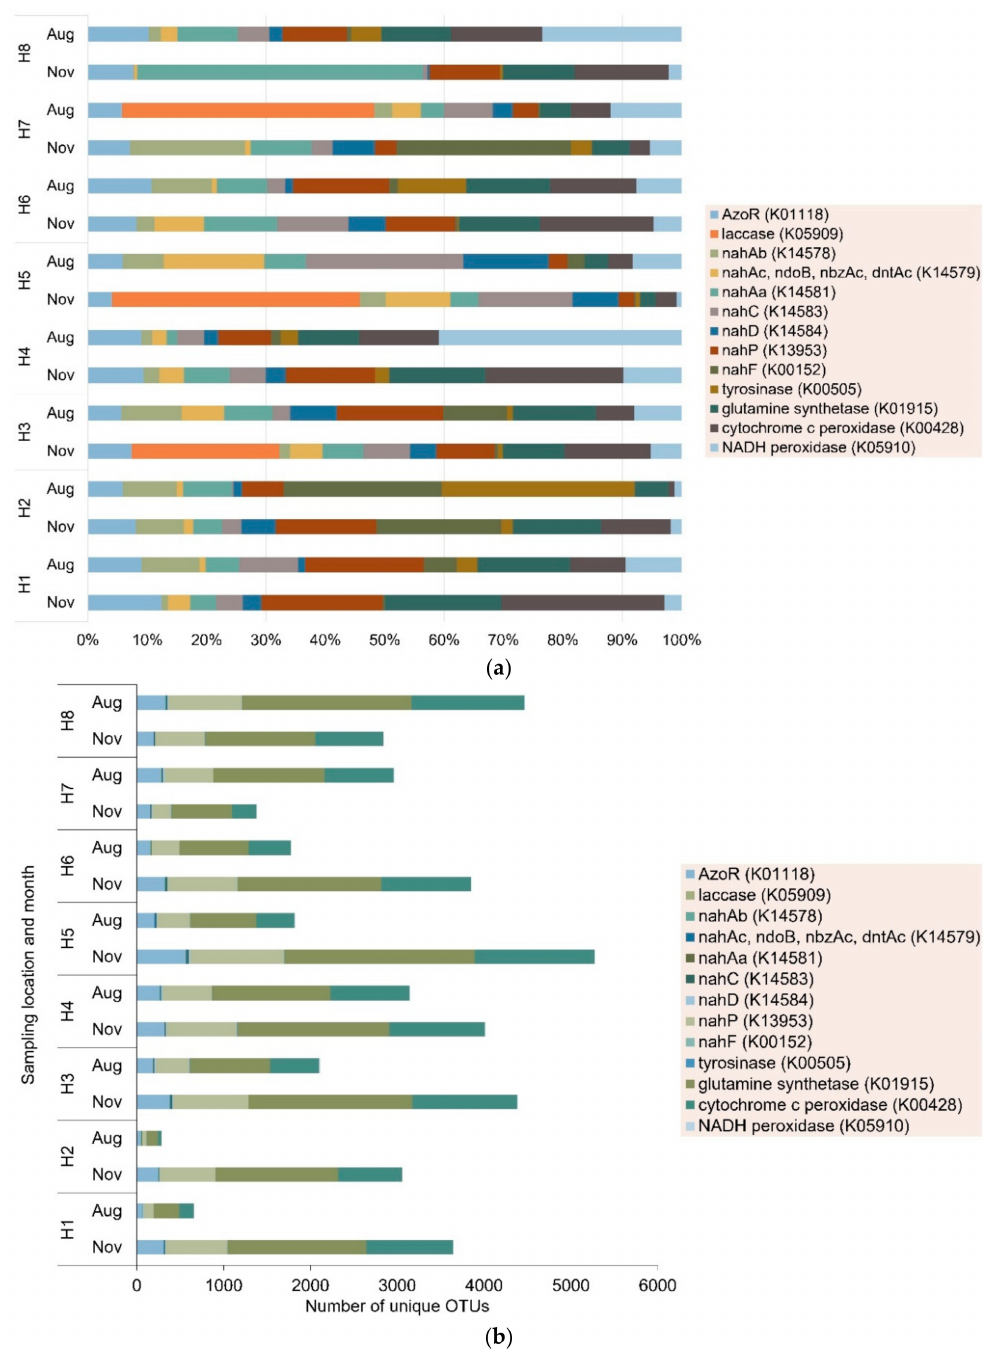
Figure 3. The ( a ) relative abundance and ( b ) operational taxonomic unit (OTUs) of the annotated functional genes involved in synthetic azo dye